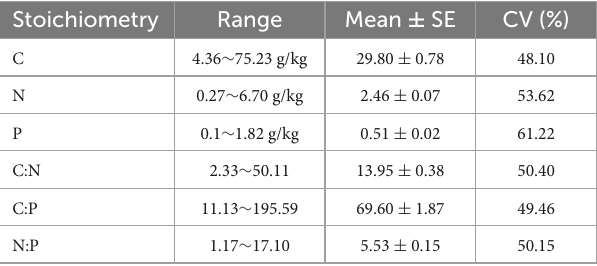
TABLE 1 Descriptive statistic of soil C, N, and P stoichiometry in forest on Guangxi Province.